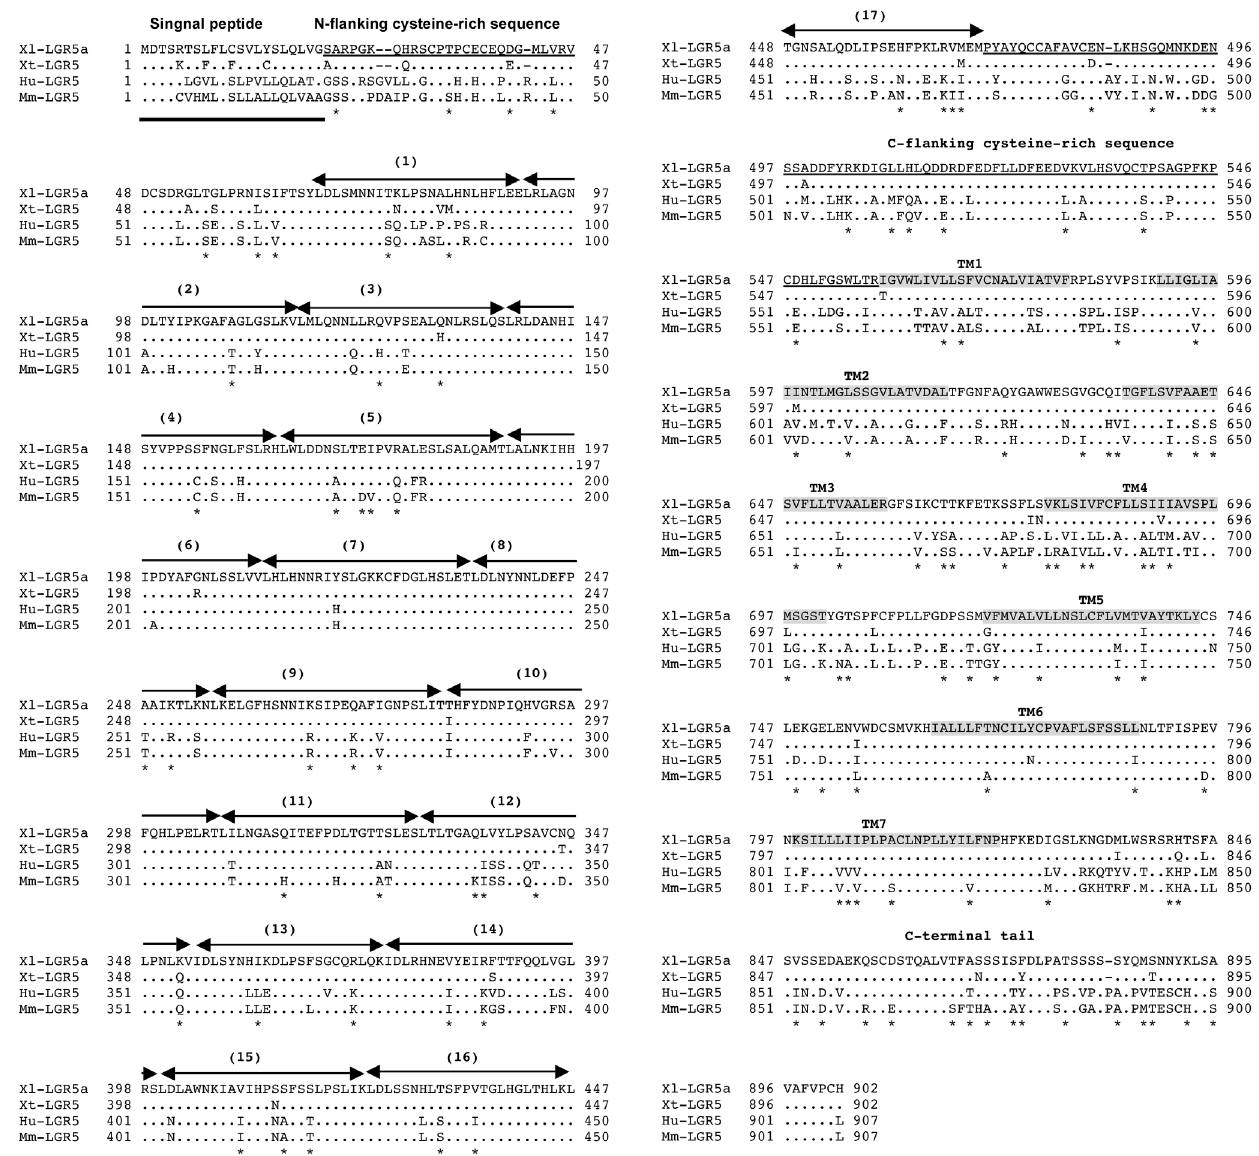
Figure 1. The X.laevis (Xl) LGR5 shares a high degree of homology with X.tropicalis (Xt), human (Hu) and mouse (Mm) LGR5. There are two duplicated LGR5 genes in X. laevis and only one (Xl-LGR5a) was used for comparison. The deduced amino acid (aa) sequences were aligned and gaps were introduced to achieve best alignments among species. Dots indicate the aa are the same as that of Xl-LGR5a and conserved changes among species are marked with stars under the Mm-LGR5 sequences. Number (1) to (17) indicate the highly conserved leucine-rich repeats. The conserved transmembrane domains are indicated with TM1-7. The N-terminal signal peptide, N-, C-flanking cysteine-rich sequences, and C-terminal tail are not well conserved.